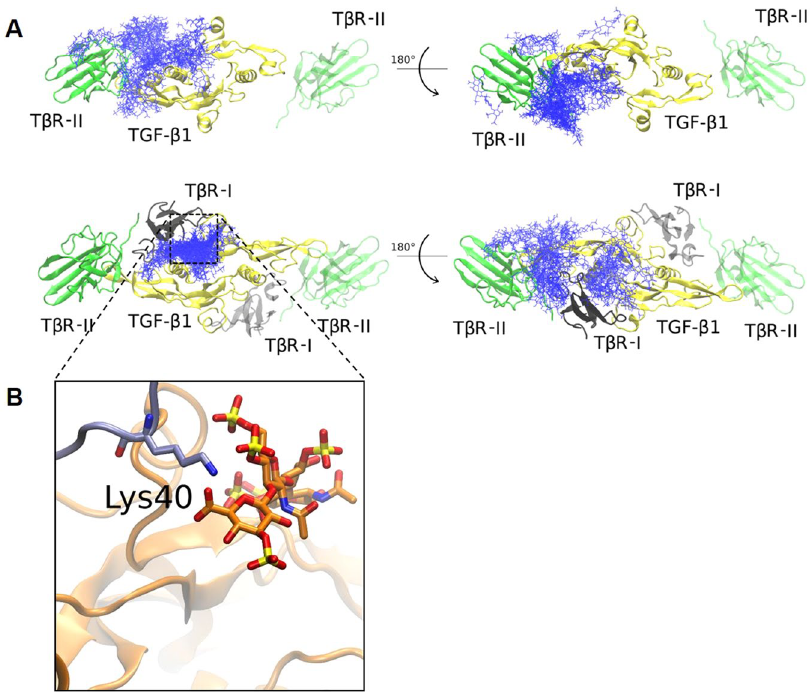
Figure 4. Molecular Modeling of the TGF- β 1/T β R-I/T β R-II/GAG System. ( A ) Docking results for HA463 ′ dp4 (top 50 solutions, in blue sticks) to TGF- β 1/T β R-II (top) and TGF- β 1/T β R-II/T β R-I (bottom). TGF- β 1 is shown in yellow, T β R-II in green and T β R-I in grey. The part of the system not used for docking calculations (T β R-I and T β R-II on the right side of TGF- β 1) is depicted with transparency. ( B ) Zoomed view of the residue Lys40 of T β R-I (in thick sticks, carbons in cyan) that interacts with the negatively charged groups of HA463 ′ dp4 (in thick sticks, carbons in orange). Protein is shown in cartoon.